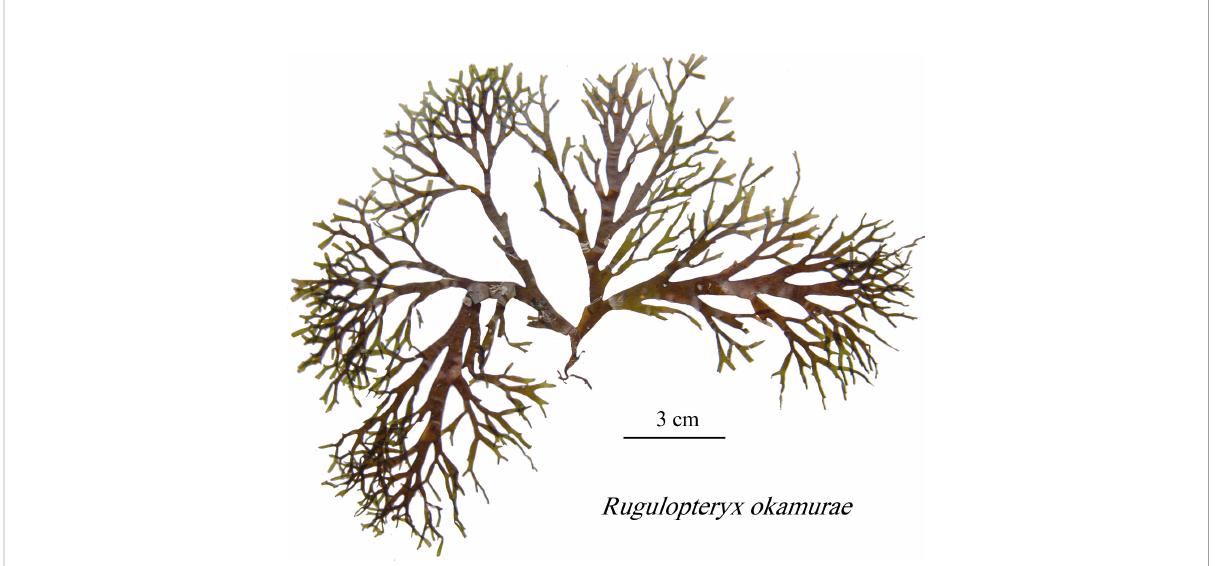
FIGURE 1 Rugulopteryx okamurae specimen sampled in Tarifa (Spain) on 1 st July